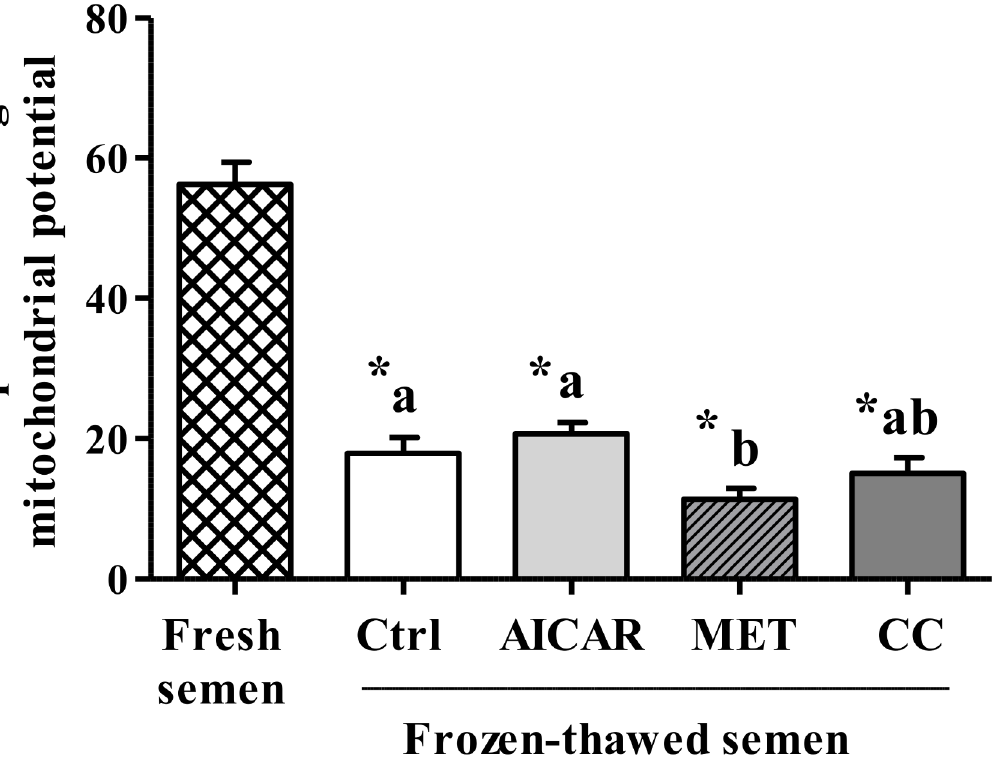
Fig 3. Effect of AMPK inhibitor CC and activators AICAR and MET in mitochondrial membrane potential of frozen-thawed sperm. Sperm were treated in the presence of an AMPK activator (2mM AICAR (in light gray) or 1mM MET (in diagonals)) or an AMPK inhibitor (5 µ M CC (in dark gray)) or Control (Ctrl, in white); Fresh semen (checkered pattern).Values represent means ± SEM from 6 different experiments (4 samples/experiment). Different superscripts indicate significant differences between Ctrl and treatments (AICAR, MET or CC) in frozen-thawed semen ( a,b , P < 0.05). Asterisks indicate statistically significant differences between fresh and frozen-thawed semen ( * , P <